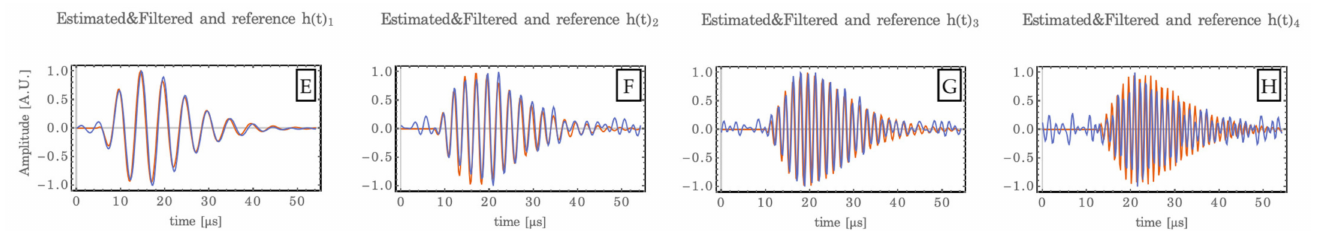
Figure 5. Estimated h k ( t ) kernels in the case SNR 1 = 10 [dB] (blue lines) and reference kernels (red lines). Plots ( A – D ): h 1 ( t ) , h 2 ( t ) , h 3 ( t ) , h 4 ( t ) estimates before lowpass filtering and reference. Plots ( E – H ): h 1 ( t ) , h 2 ( t ) , h 3 ( t ) , h 4 ( t ) estimates after lowpass filtering and reference.